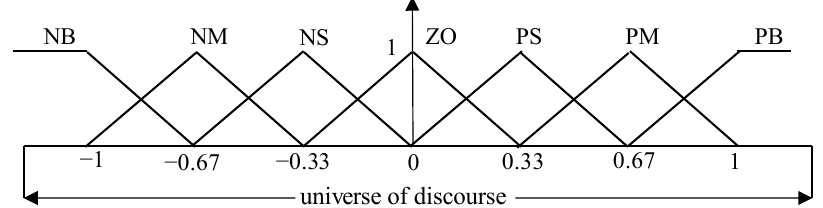
Figure 5. The output trigonometric membership functions of the fuzzy-PID controller.